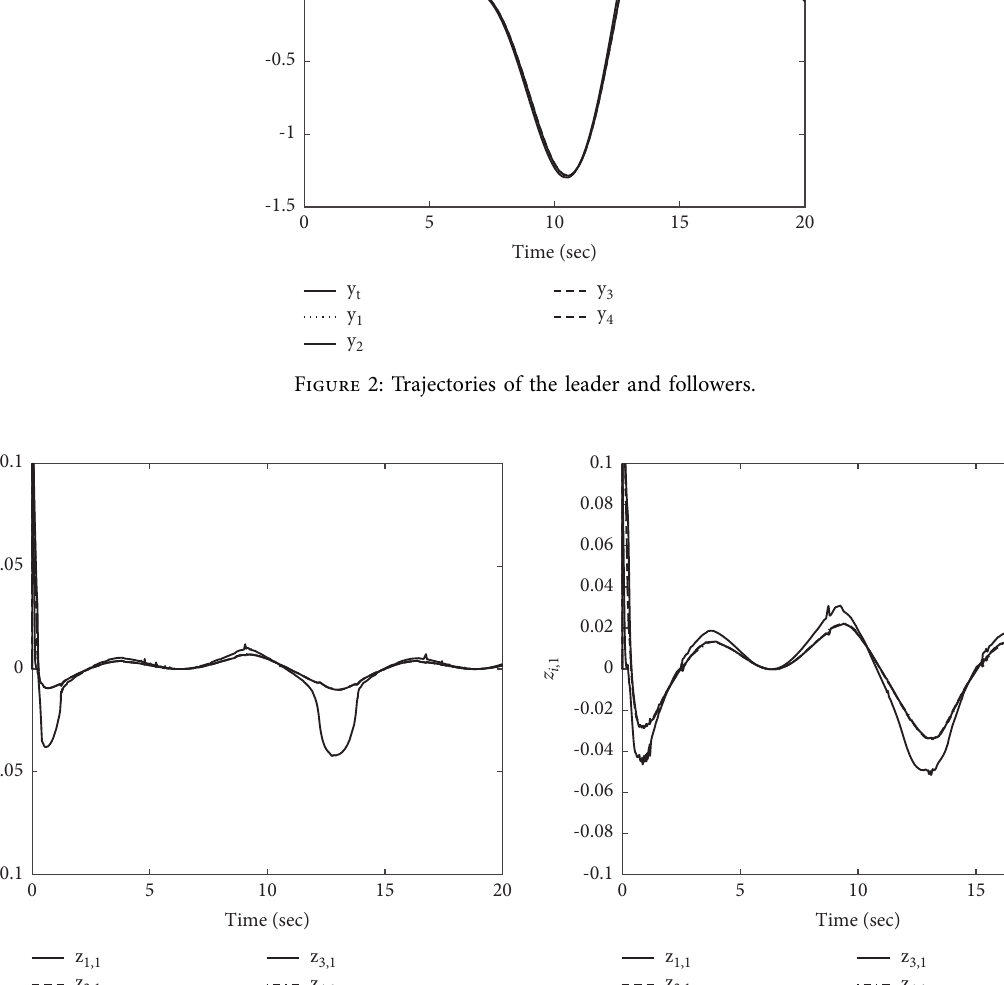
i ≤ 4 and ε � 0 . 05. (b) Tracking errors z i, 1 for 1 ≤